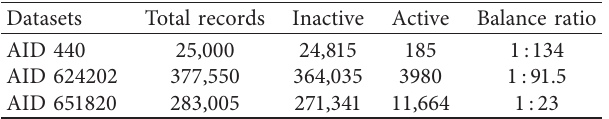
Table 1: Benchmark imbalanced dataset.